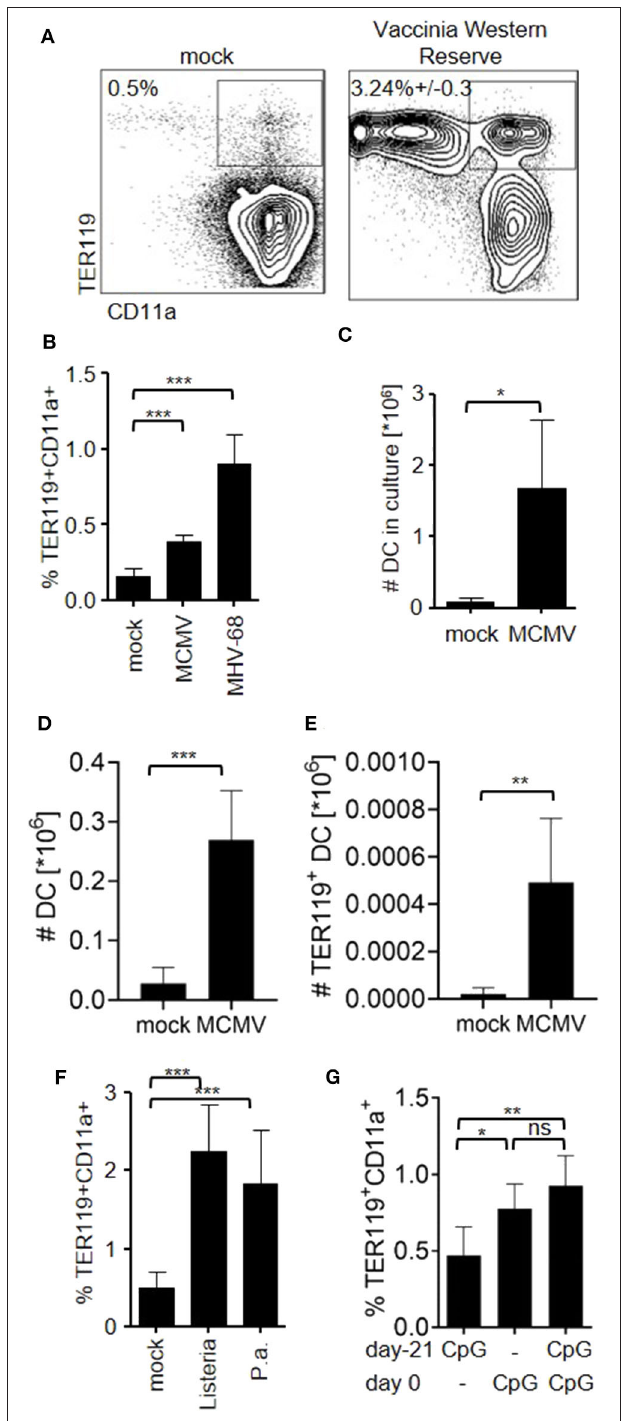
FIGURE 4 | Viral and bacterial infections induce the expansion of TER119 + inflammatory DC. (A) Mice were infected with vaccinia virus Western Reserve. Blots show TER119 and CD11a expression on splenocytes at day 6 post-infection. Data of the animal representing the median of n = 5 animals are shown. (B–E) Mice were infected with mouse cytomegalovirus (MCMV) or MHV-68. Graphs show (B) proportion of TER119 + CD11a + splenocytes at day